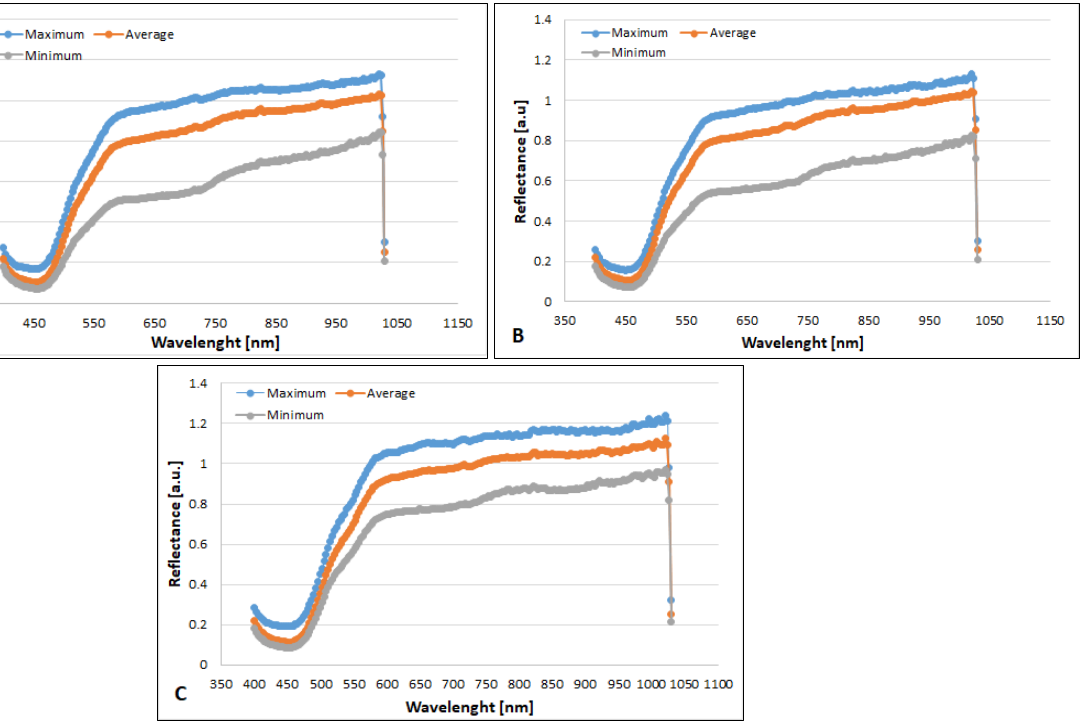
Figure 6. Hyperspectral profiles of the tested tablets: ( A ) unexpired tablets; ( B ) expired tablets; ( C ) stressed tablets. Blue, orange, and grey curves correspond to the maximum, average, and minimum reflectances, respectively. Table 6. The differences between the maximum and minimum reflectances of the analyzed tablets containing nifuroxazide.